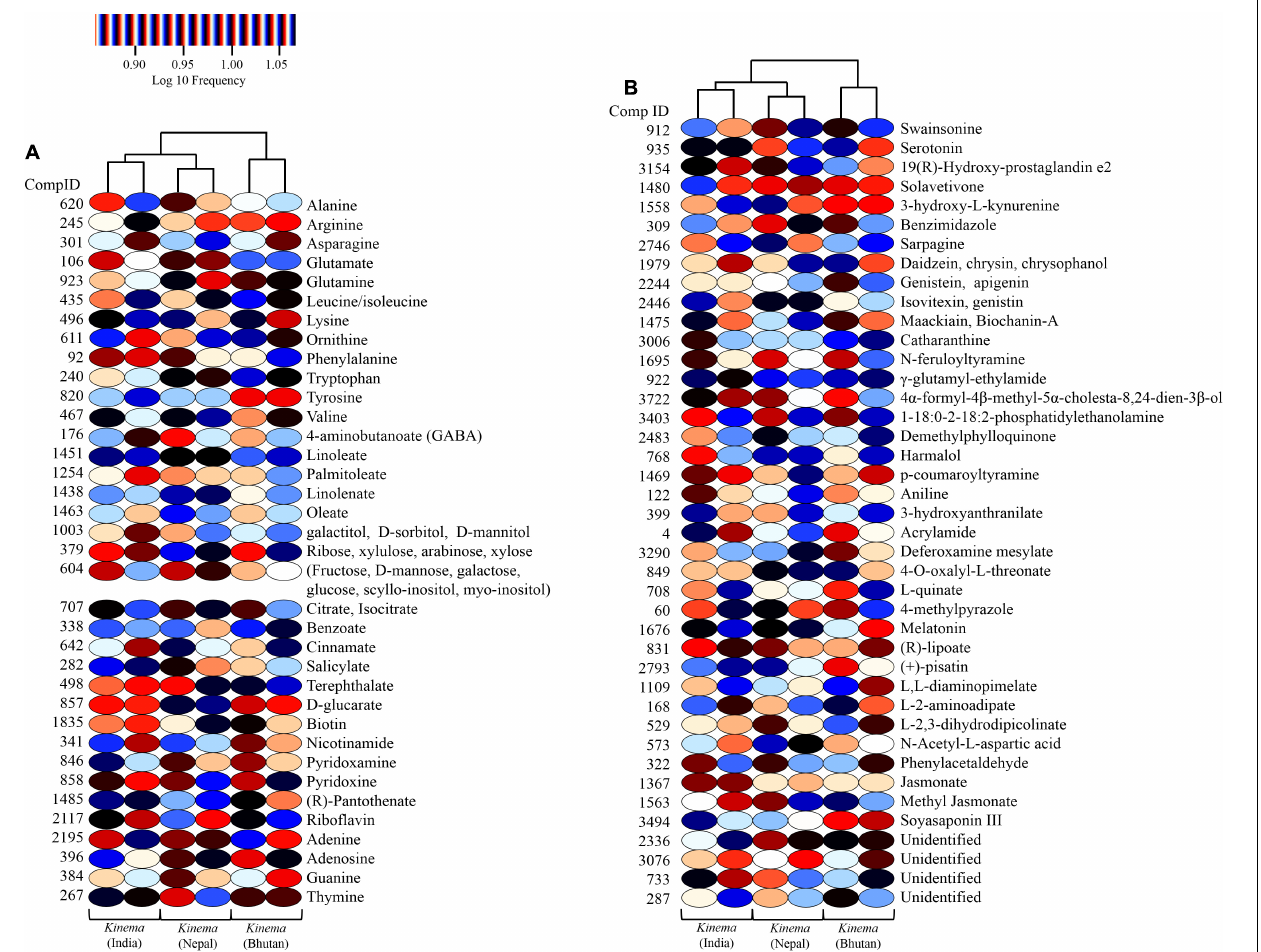
FIGURE 10 | Heatmap representation of significant metabolites ( p < 0.05) in kinema samples. (A) Significant primary metabolites include amino acids, fatty acids, sugars, organic acids, vitamins, and nucleobases. (B) Significant secondary metabolites such as isoflavones, soyasaponin, flavoring agents, and other bioactive compounds with potential therapeutic